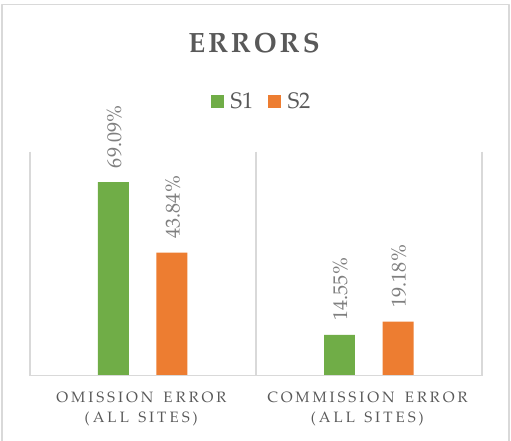
Figure 9. Omission and commission errors in all sites for the two datasets.